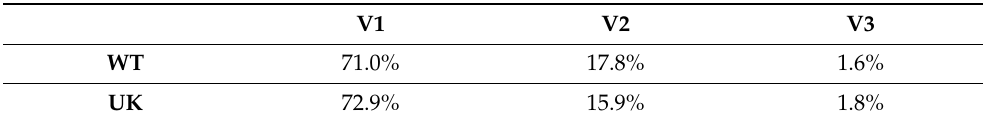
Table 1. Percentage of global motion described by ED eigenvectors 1–3 (named V1, V2, and V3, respectively) in WT and